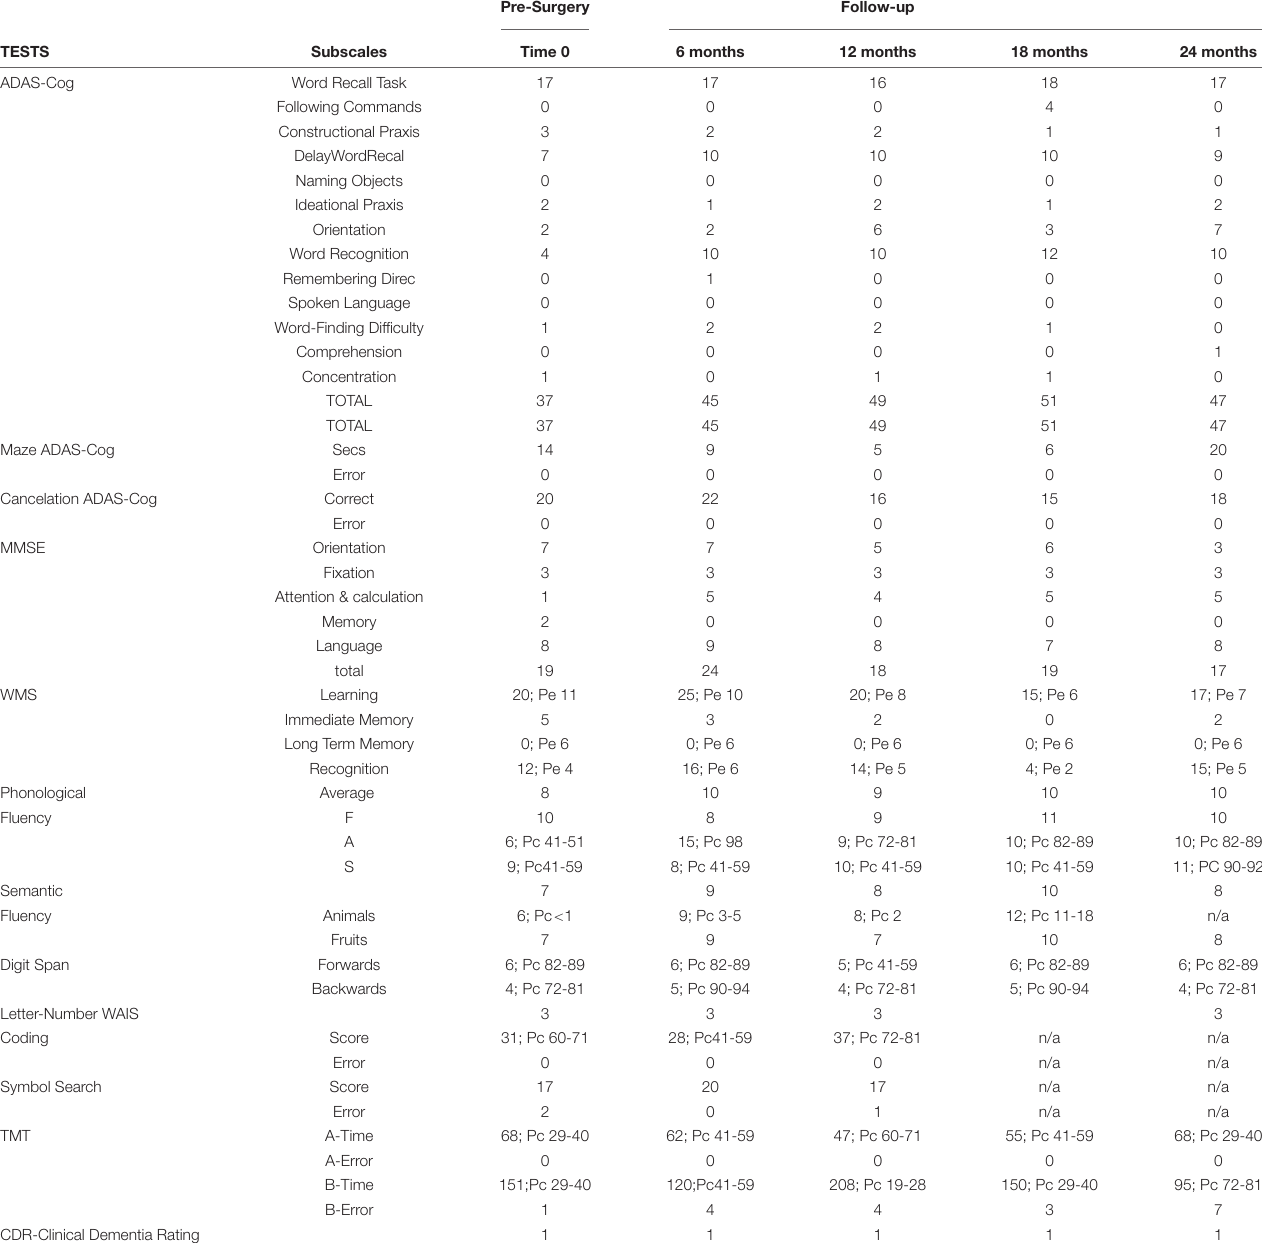
TABLE 1 | Neuropsychological and clinical scores during the